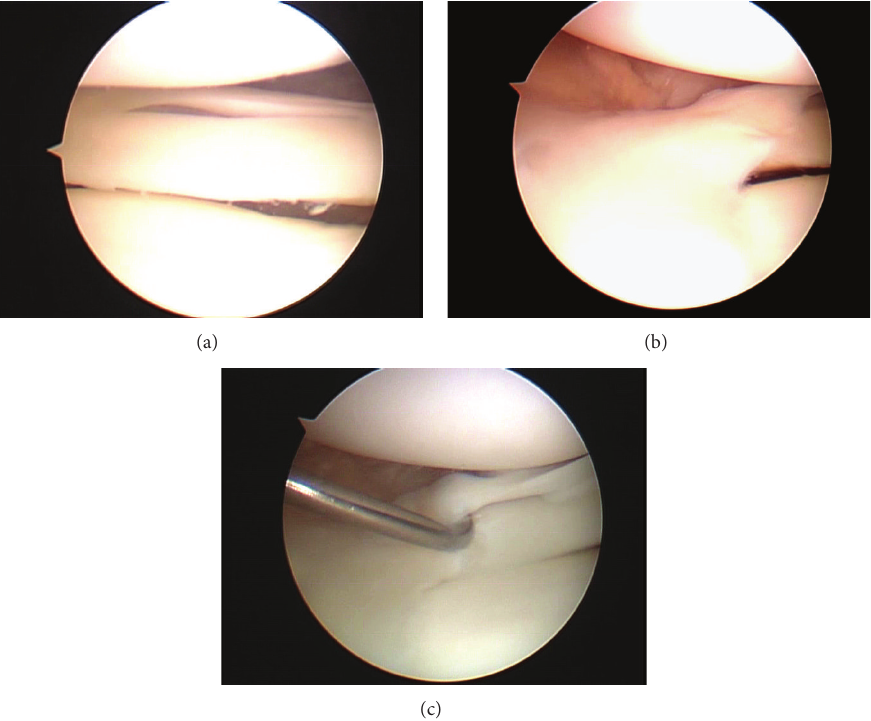
Figure 2: Arthroscopic findings of right knee. Upper accessory meniscus of posterior (a) and middle (b) segments. Anterior edge of upper layer of accessory meniscus is firmly fixed and overlaps the lower normal lateral meniscus